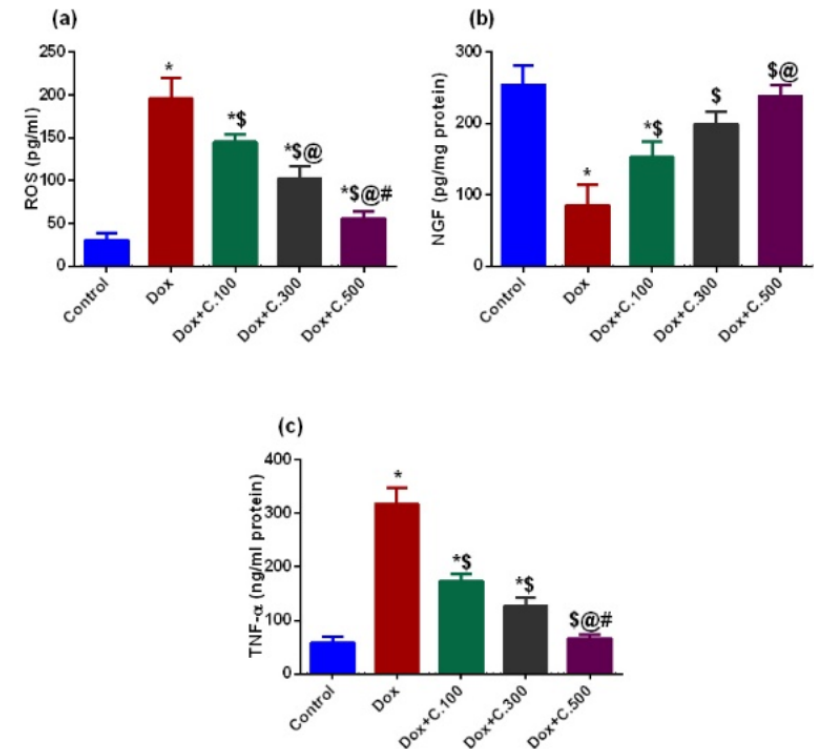
Figure 2. Effect of Dox with or without different doses of C. macrocarpa leaves polar fraction on the brain levels of ROS, NGF, and TNF- α . ( a ) Reactive oxygen species, ( b ) Nerve growth factor, and ( c ) Tumor necrosis factor-alpha. Data are expressed as mean ± SEM, one-way ANOVA followed by post hoc Tukey test for seven rats in each group. * Significant from control group, $ Significant from Dox group, @ Significant from Dox+ C.100 group, and # Significant from Dox+ C.300 group, p <